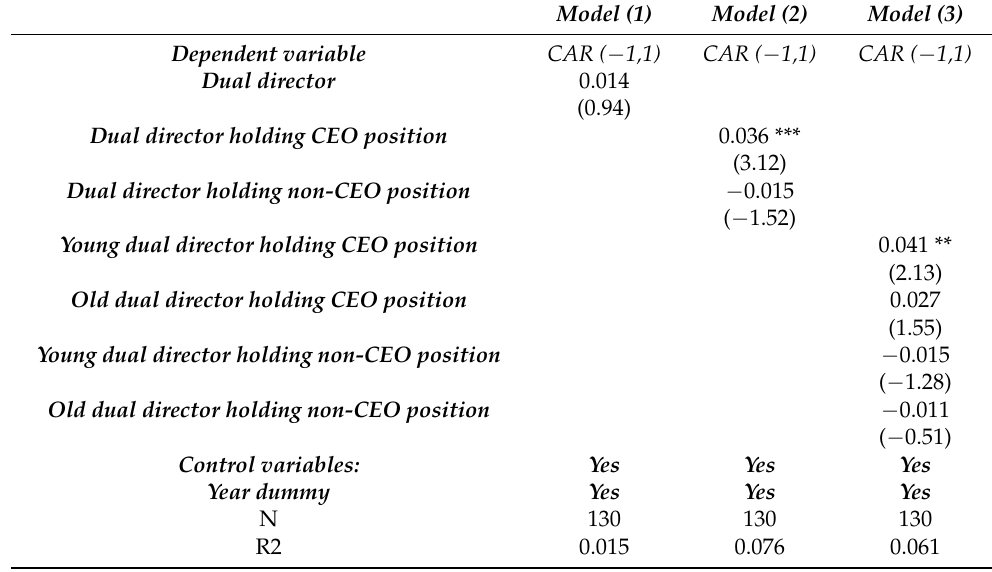
Table A4. Cross-sectional regressions of announcement period CAR. The dependent variable in all regressions is the three-day CAR surrounding the announcement day of the equity carve-out. z-statistics computed using heteroskedasticity-consistent standard errors (clustered by industry) are in parentheses. Year dummies are also included . **, and *** indicate significance at the 5%, and 1% levels,